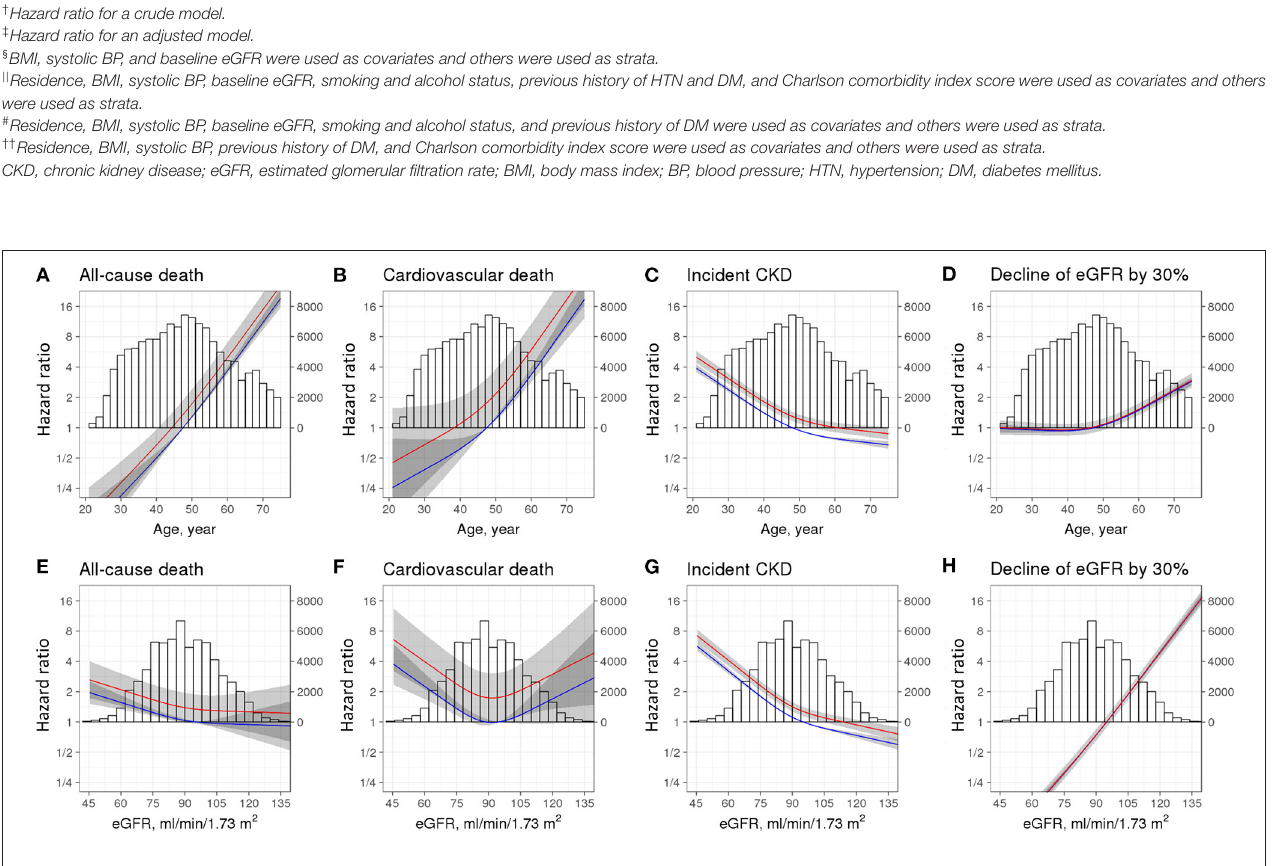
FIGURE 2 | Restricted cubic spline curves for adverse outcomes according to age, estimated glomerular filtration rate (eGFR), and groups. Hazard ratios and 95% confidence intervals were drawn according to spline age (A–D) and eGFR (E–H) . Adverse outcomes included all-cause death (A,E) , cardiovascular death (B,F) , incident CKD (C,G) , and decline of eGFR by 30% (D,H) . Models were adjusted for age, sex, residence, income level, BMI, systolic BP, eGFR, Charlson comorbidity index score, history of HTN and DM, and smoking and alcohol status. The reference was age of 47.5 years (A–D) and eGFR of 95 ml/min per 1.73 m 2 (E–H) plus no albuminuria group. Red line, transient albuminuria group; Blue line, no albuminuria group. CKD, chronic kidney disease; eGFR, estimated glomerular filtration rate; BMI, body mass index; BP, blood pressure; HTN, hypertension; DM, diabetes mellitus.